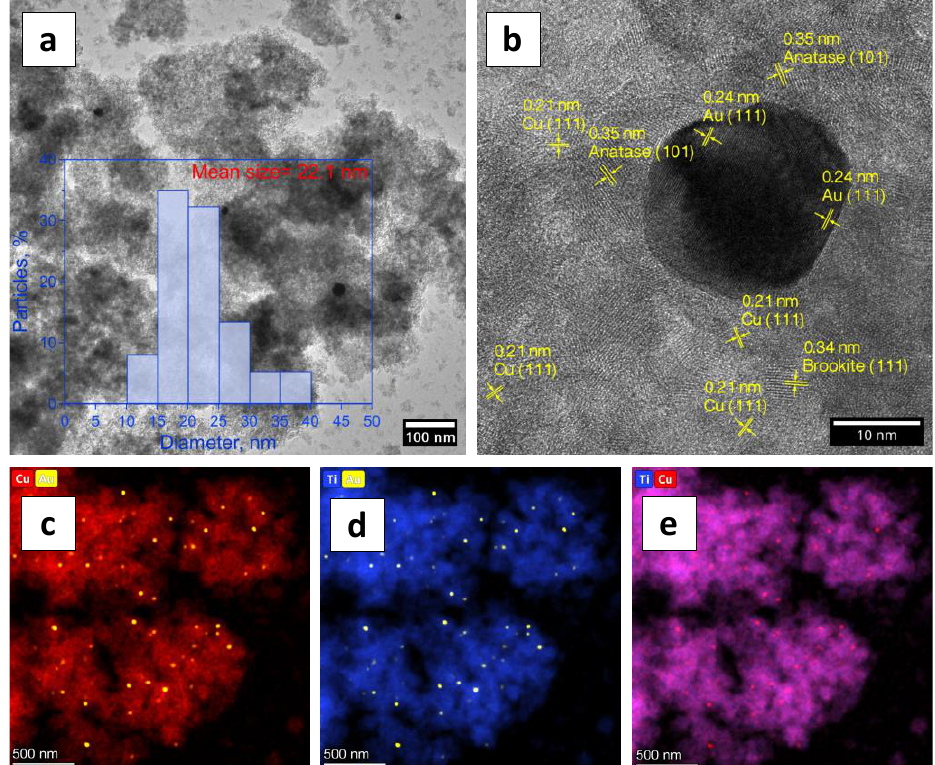
Figure 4. TEM images of the obtained CuA-Au/TiO 2 sample: SE mode with a particle size distribution ( a ), SE mode ( b ), EDS HAADF analysis of Cu ( c ) and Au, EDS HAADF analysis of Ti and Au ( d ), and EDS HAADF analysis of Ti and Cu ( e ).